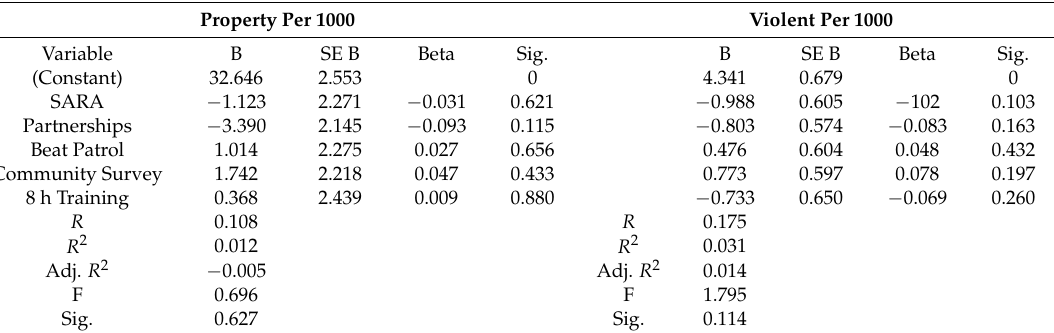
Table 2. Multiple Regression Model for Individual COP Variables and Property and Violent Crime Rates ( n = 309).